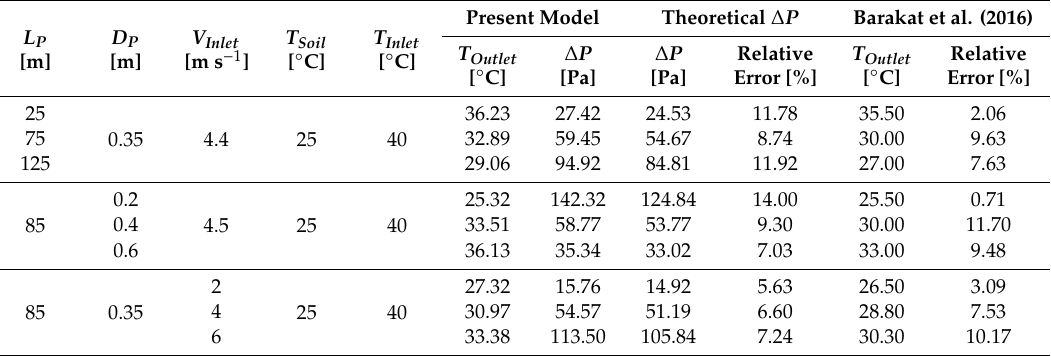
Table 6. Results of model validation 2.